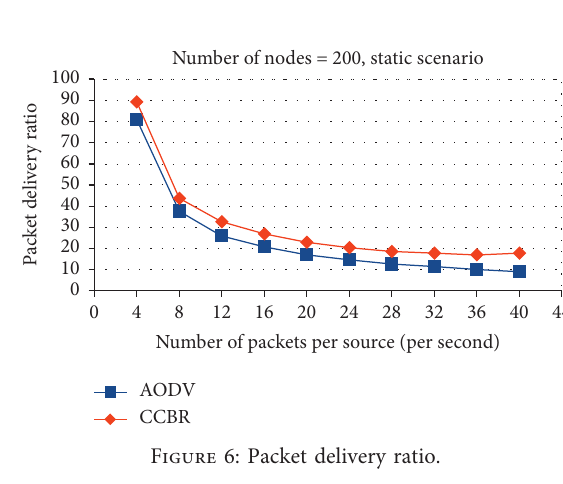
Figure 5: Packet delivery ratio.